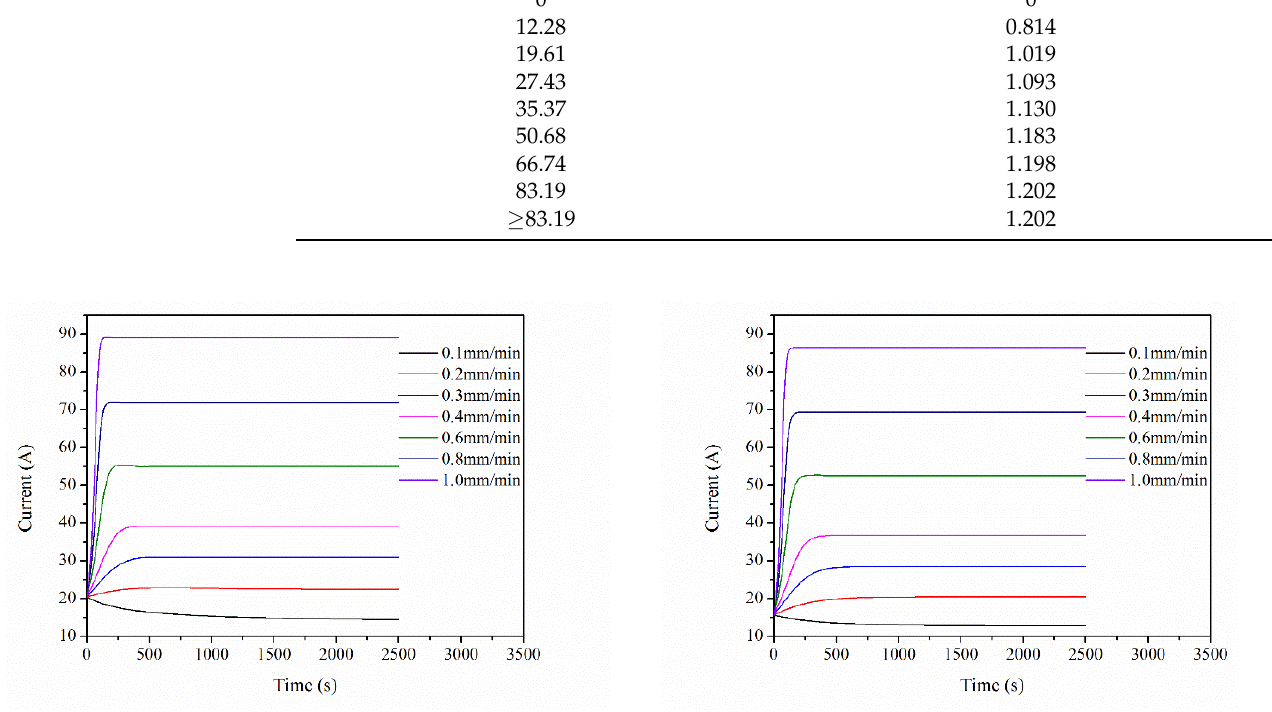
Figure 6. Diagrams of the current evolutions.